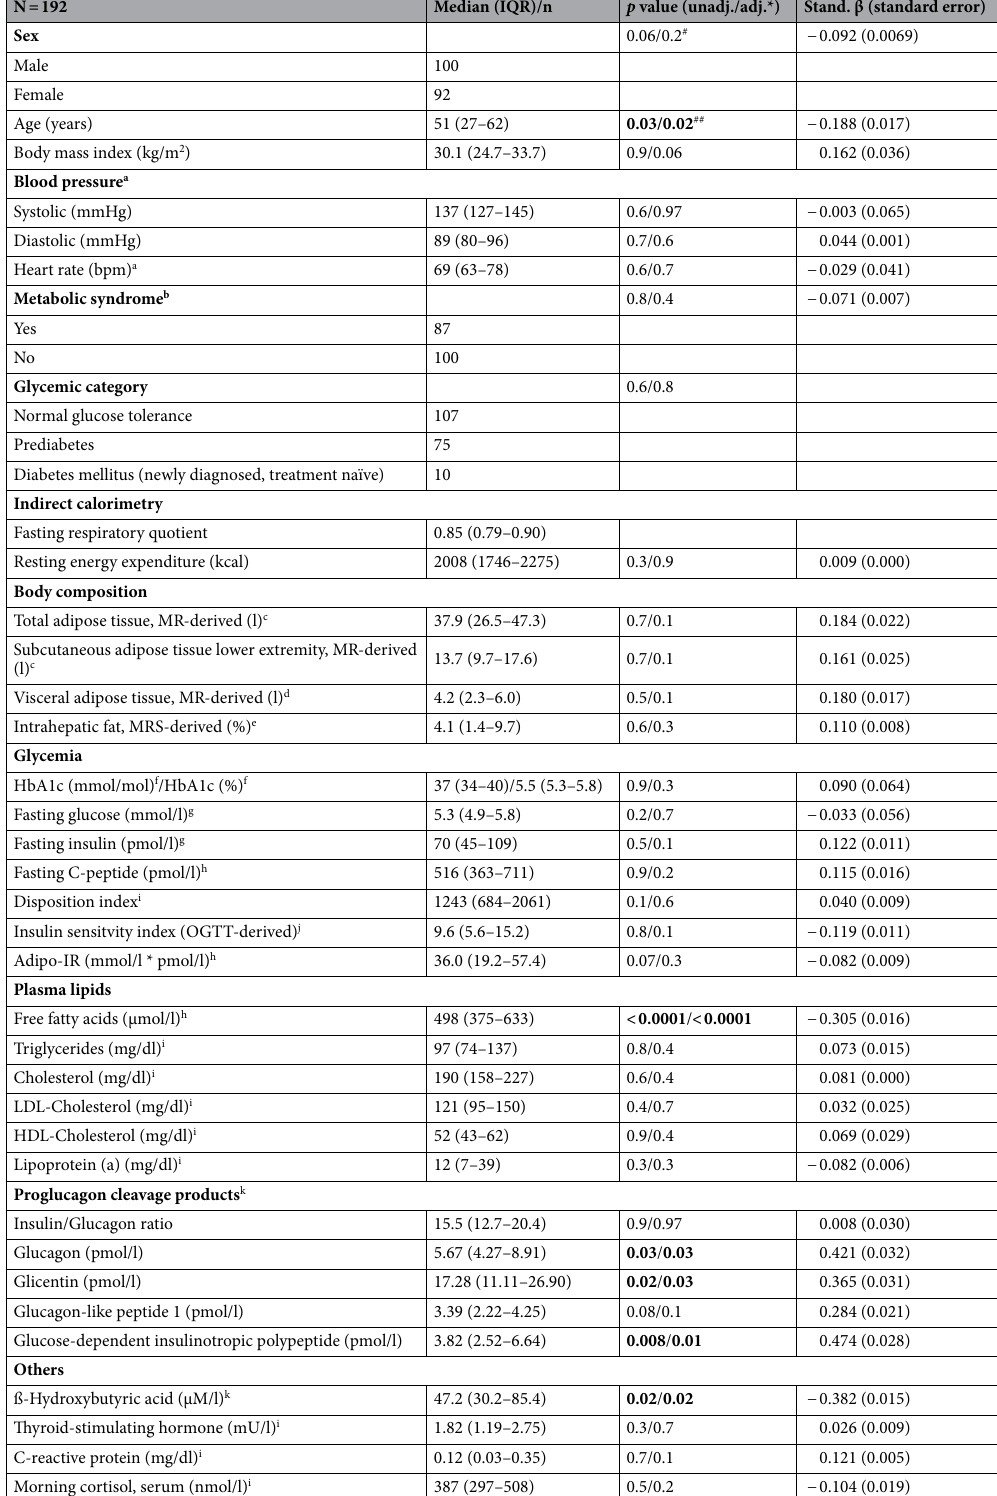
Table 1. Associations with respiratory quotient (RQ). MR magnetic resonance, MRS magnetic resonance spectroscopy, HbA1c hemoglobin A1c, OGTT oral glucose tolerance test, Adipo-IR adipose tissue insulin resistance index, LDL-Cholesterol low-density lipoprotein cholesterol, HDL-Cholesterol : high-density lipoprotein cholesterol. *Adjusted for sex and age; # adjusted for age; ## adjusted for sex and BMI. Standardized ß are from multivariate linear regression models. a : n = 190; b : n = 187; c : n = 137; d : n = 139; e : n = 140; f : n = 178; g : n = 191; h : n = 181; i : n = 179; j : n = 184; k : n = 38. p < 0.05 are printed in